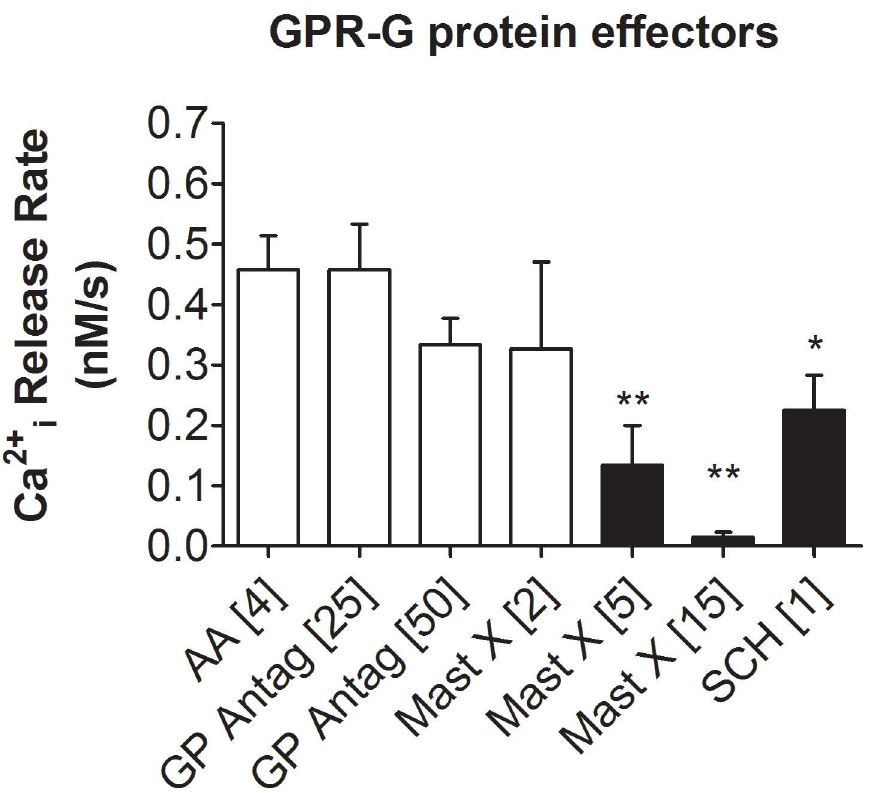
Fig 3. GPR/G protein modulators. Effects of GPR/G-protein modulators on the AA-induced(4 μ M) release of Ca 2+ from intracellularstores. Bracketednumbers in the Figure represent the chemicalfinal concentration in solution.SubstanceP-G protein antagonist peptide(25 and 50 μ M), Mastoparan X (inhibitorof G protein receptorbinding,2, 5 and 15 μ M) and SCH202676 (inhibitorof agonist and antagonist bindingto G-protein- coupledreceptors, 1 μ M) were addedto the cells in suspension and incubatedfor 5 min at 33˚C before AA addition.Each bar represents the data obtainedfrom three different cell preparations (N = 3). Significance (Black bars): ** , p < 0.01; * , p <